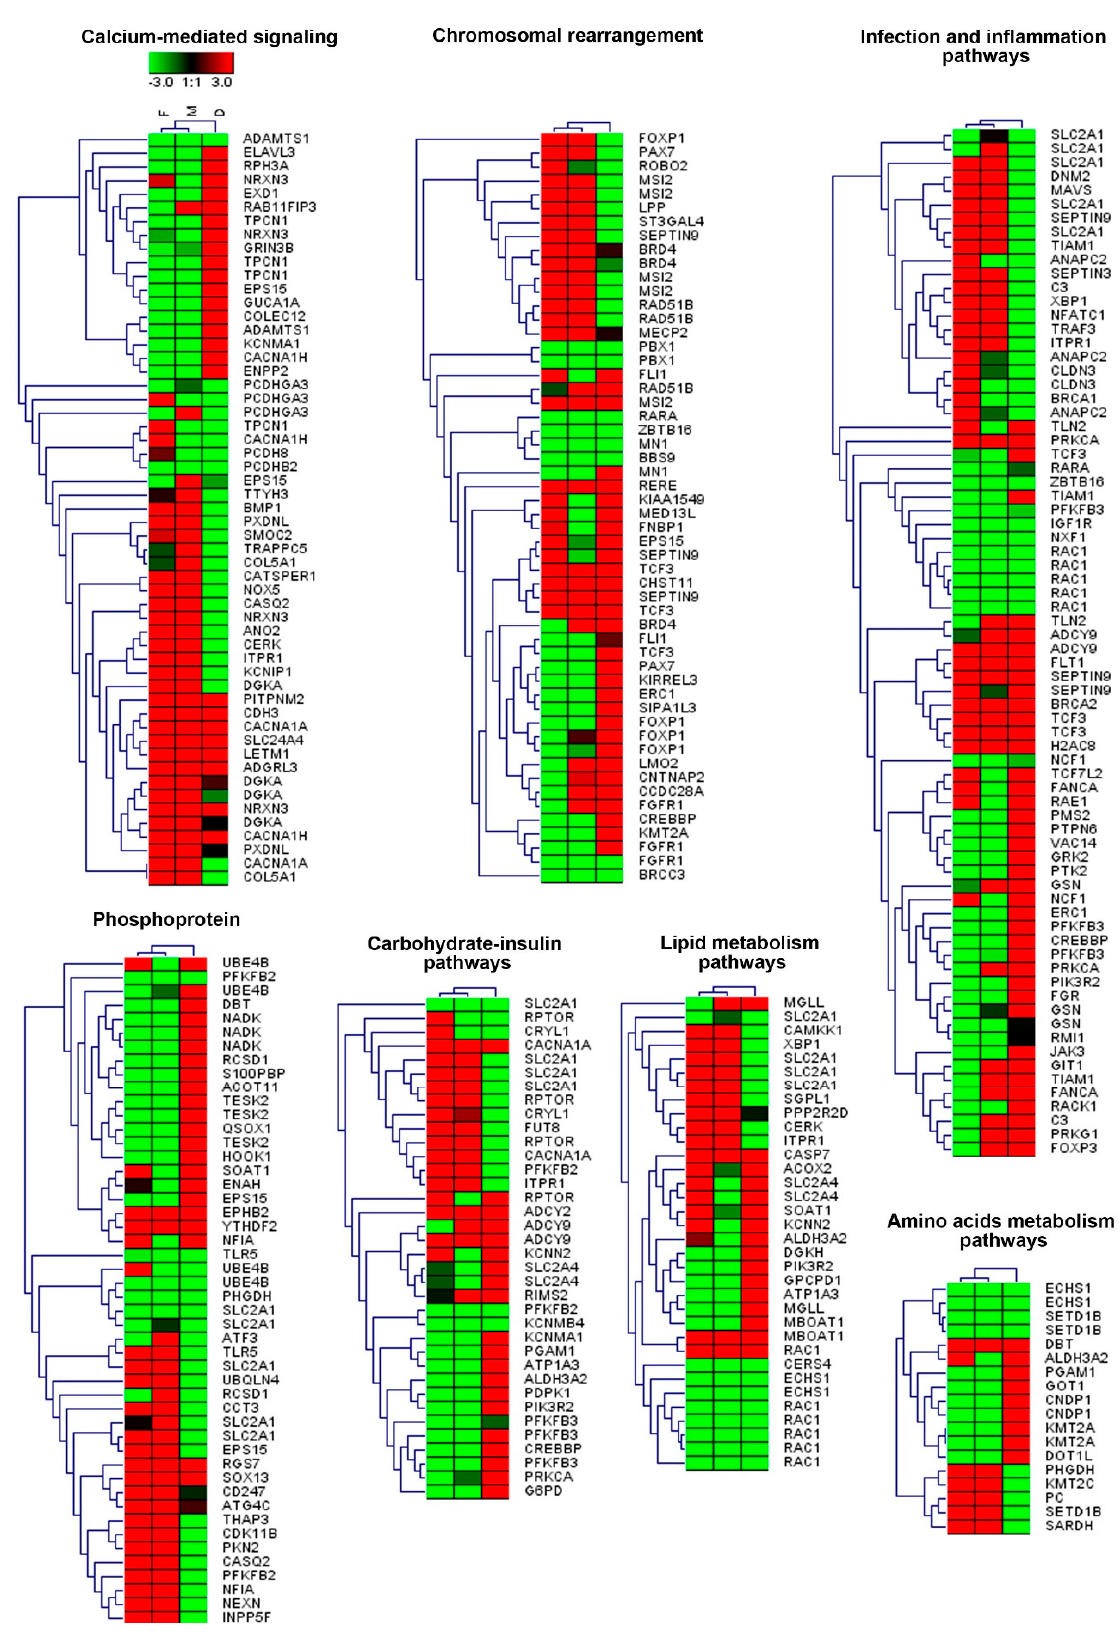
Figure 4. The heatmap analysis of the DMS-associated genes overrepresented for gene ontology (GO) terms and molecular pathways including DMS-specific percentages of methylation for the father (F), mother (M) and daughter (D). Heatmaps were generated using Genesis 1.8.1.